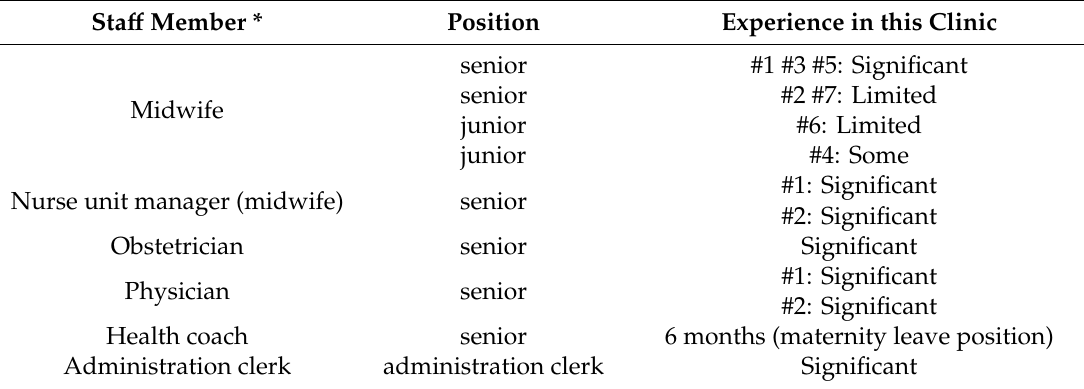
Table 2. Demographic characteristics of